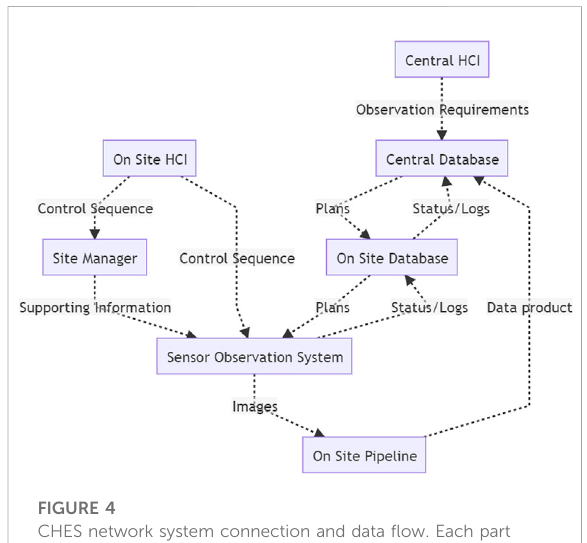
CHES network system connection and data fl ow. Each part runs a set of closely connected programs from this software kit and work together by exchanging different types of